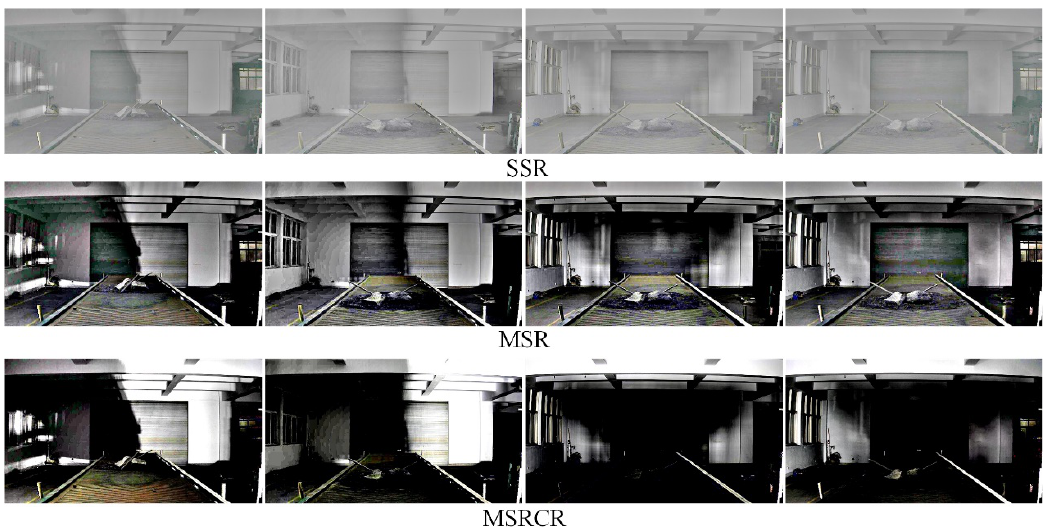
Figure 11. Enhancement of images in the dark by traditional algorithms.